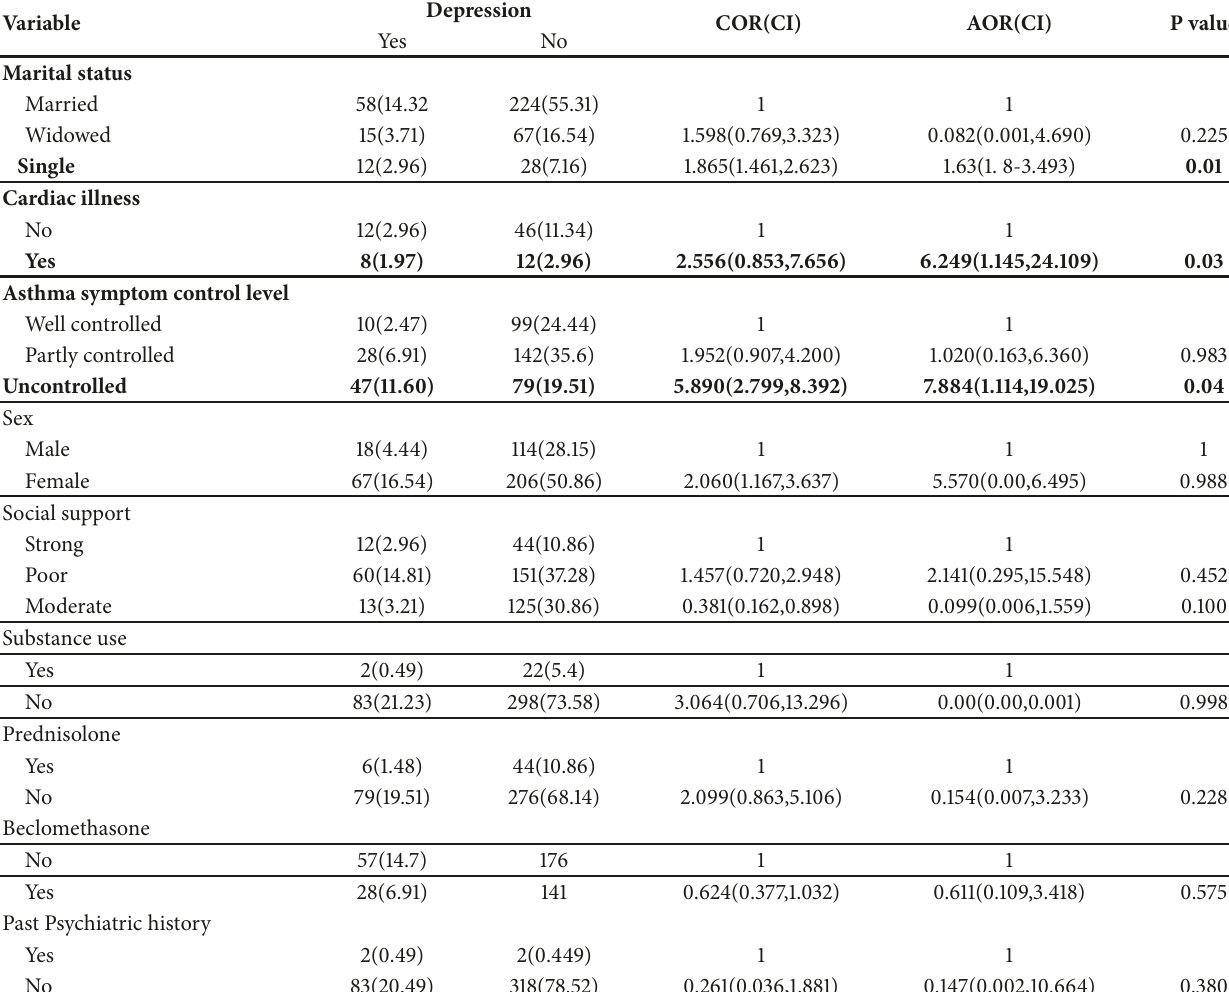
Table 2: Bivariate and multivariate logistic analysis result of study subjects among asthma patients at governmental hospitals Addis Ababa, Ethiopia,